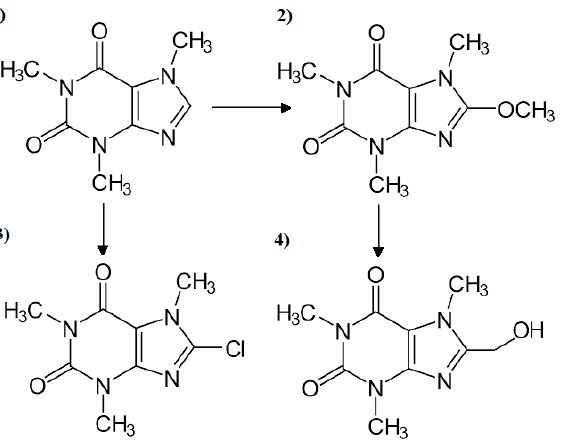
Figure 9. ( 1 ) CAF decomposition by-products: ( 2 ) 8-Methoxycaffeine, ( 3 ) 8-Chlorocaffeine and ( 4 ) 8- Hydroxymethylcaffeine.